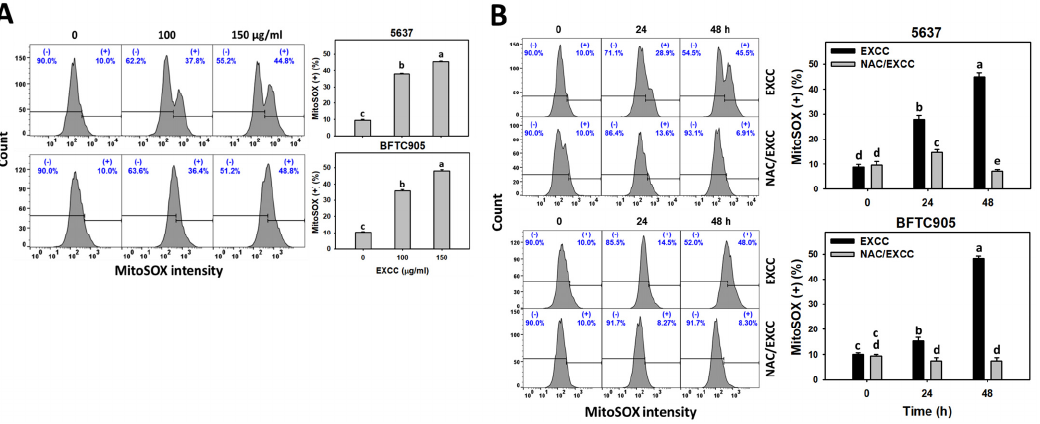
Figure 7. MitoSOX change by EXCC. ( A ) MitoSOX assay of EXCC. Two bladder cancer cell lines (5637 and BFTC905) were tested. Cells were treated with control (0.1% DMSO) and EXCC (100 and 150 μ g/mL) for 48 h. (+) represents MitoSOX (+) population. ( B ) MitoSOX assay of NAC/EXCC. NAC/EXCC is the NAC pretreatment (10 mM, 1 h) coupled with EXCC posttreatment (150 μ g/mL, 24 and 48 h). Statistical lower-case letters were given to each treatment. Non-overlapping letters between different treatments indicate significant results ( p < 0.05). Data, means ± SD ( n = 3). For example (5637 cells in Figure 7B), the EXCC (black color) 0, 24, and 48 h indicating “d, b, and a” show significant results between each other because these letters were non-overlapping. In contrast, EXCC 0 (black color) and NAC/EXCC (gray color) 0 h indicating “d” show nonsignificant results because these letters overlap.